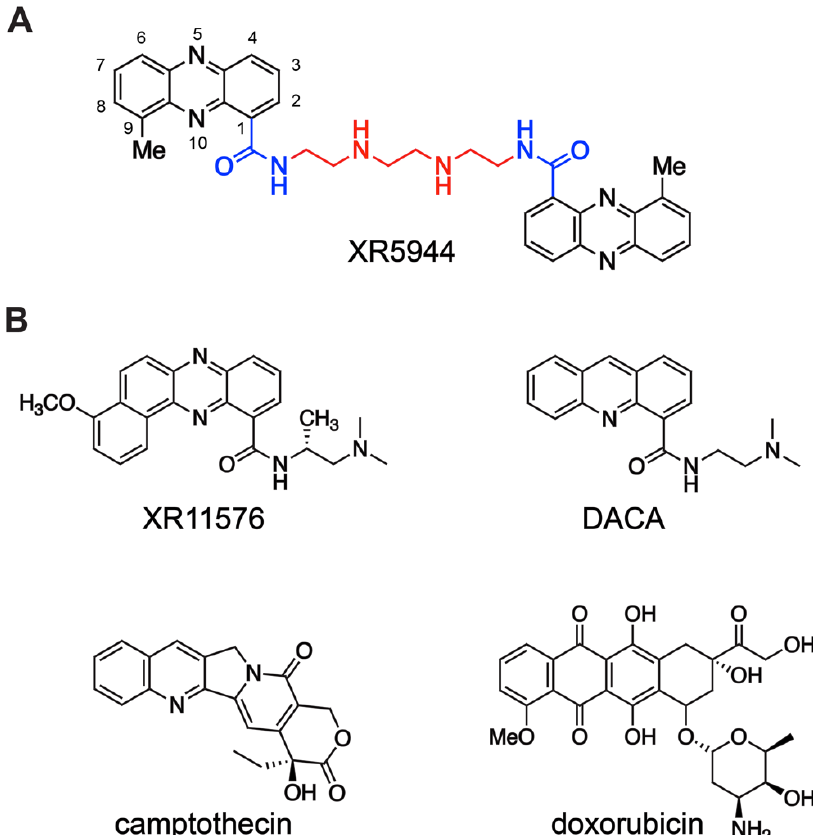
Figure 1. ( A ) Chemical structure of XR5944, bis(9-methylphenazine-1-carboxamide). Carboxamide substituents (blue) of each 9-methylphenazine chromophore (black) are coupled via a diamine linker (red). ( B ) Chemical structures of related monomer compounds XR11576 and DACA (top) and topoisomerase I inhibitor camptothecin and topoisomerase II inhibitor doxorubicin (bottom).